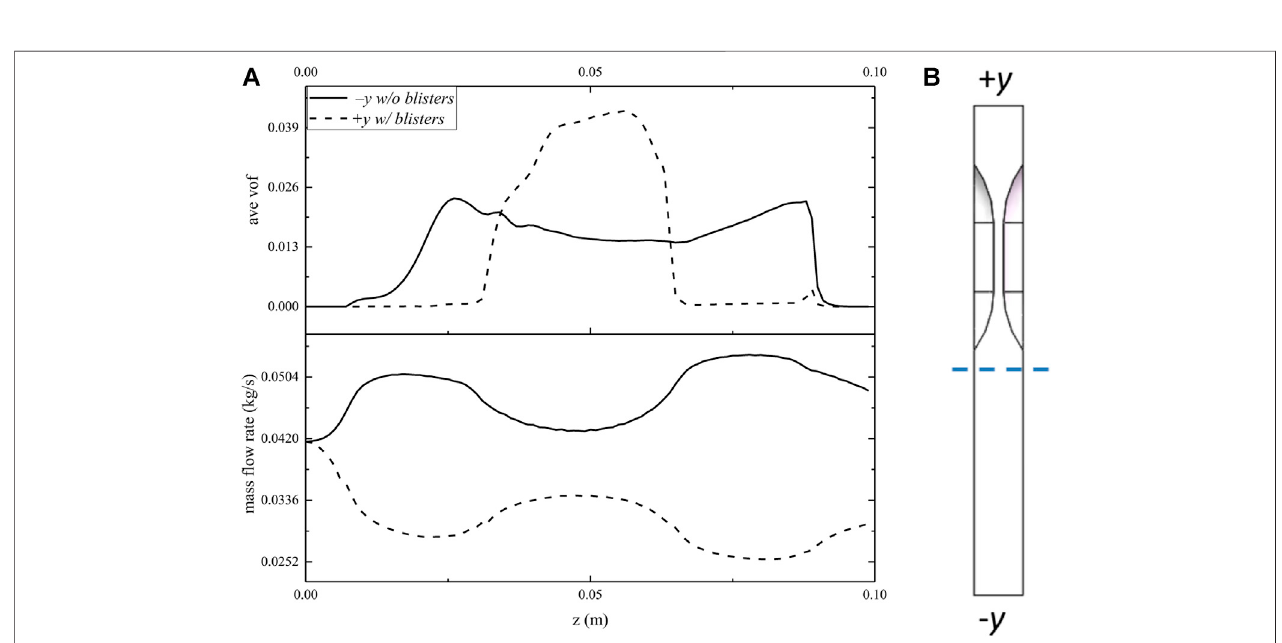
FIGURE 12 | Average void fraction and fl ow rate in cross